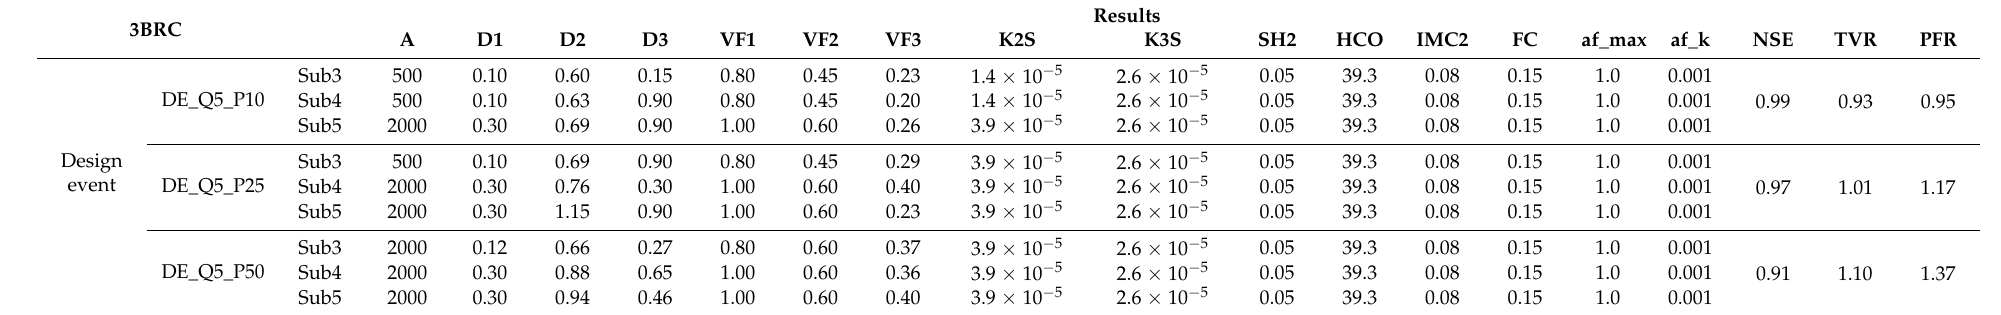
Table A6. The results of the 3BRC scenario, which includes three types of a bio-retention